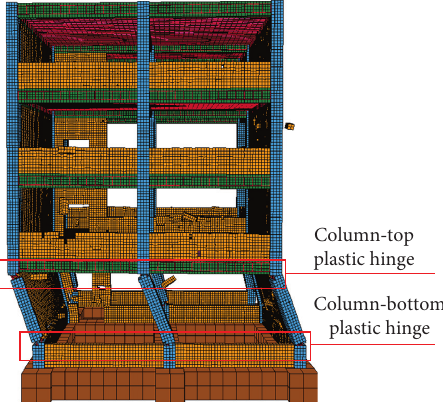
Figure 29: First-floor failure state of the simulation (front).